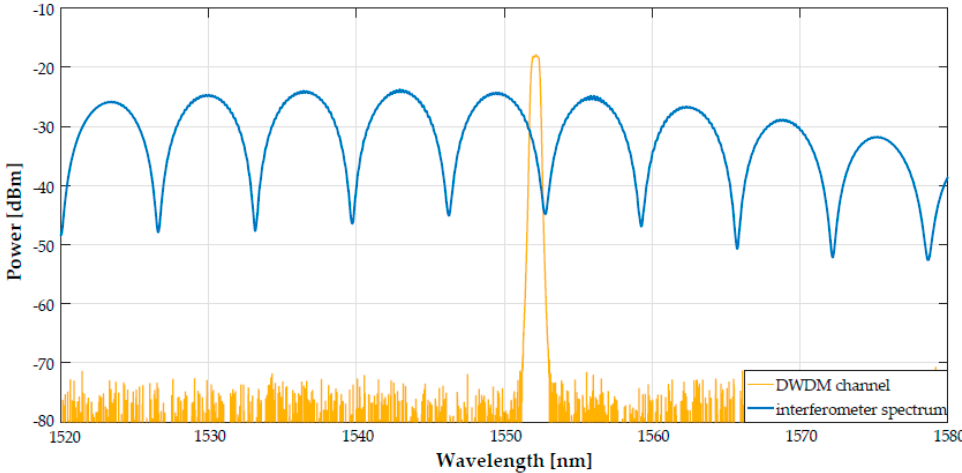
Figure 3. The spectrum of selected DWDM channel and PM-PCF Sagnac loop interferometer.